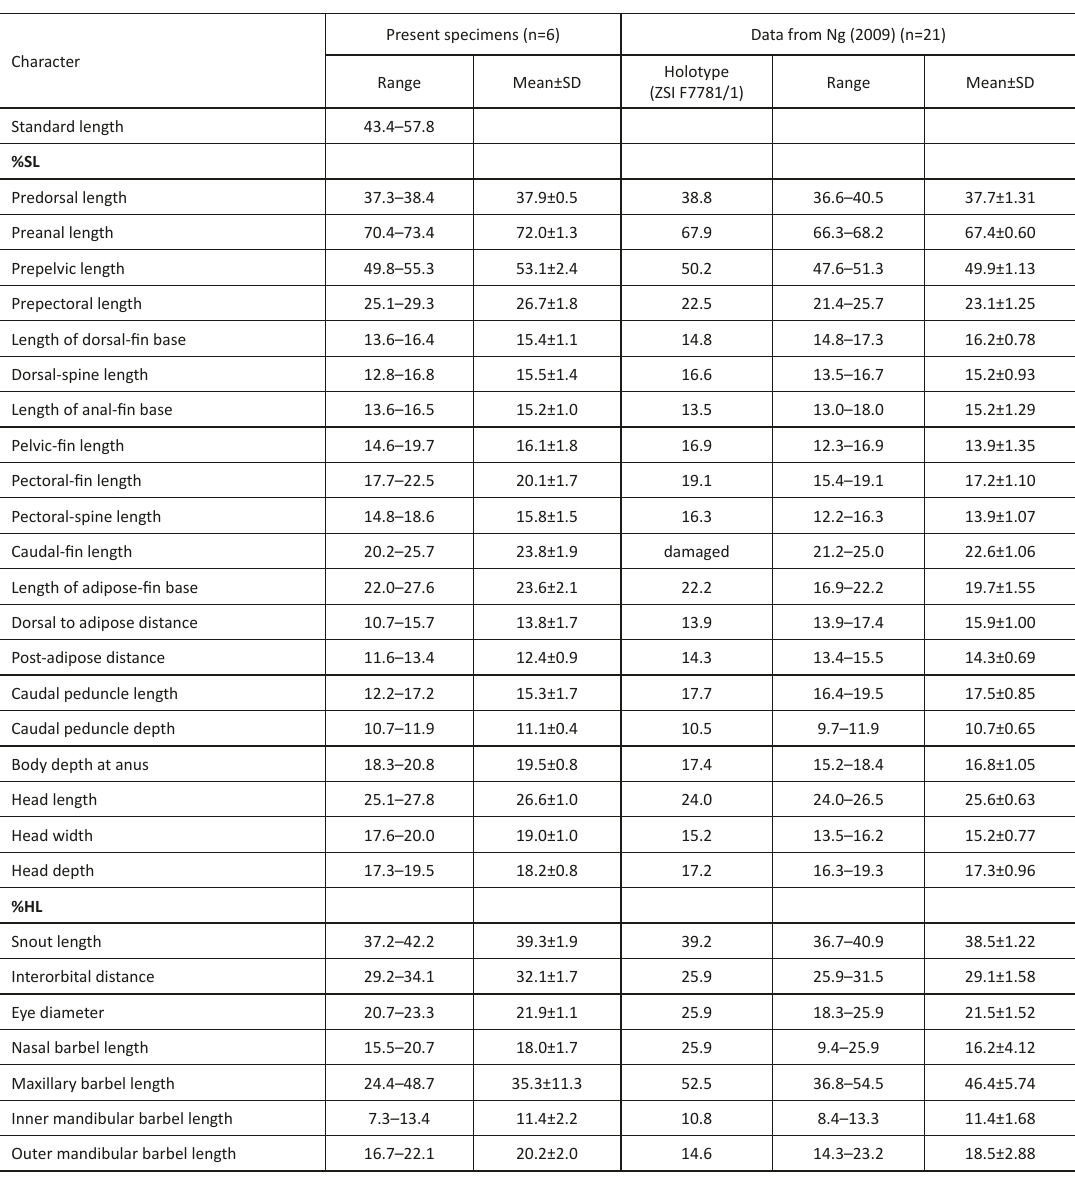
Table 1. Morphometric data of B.